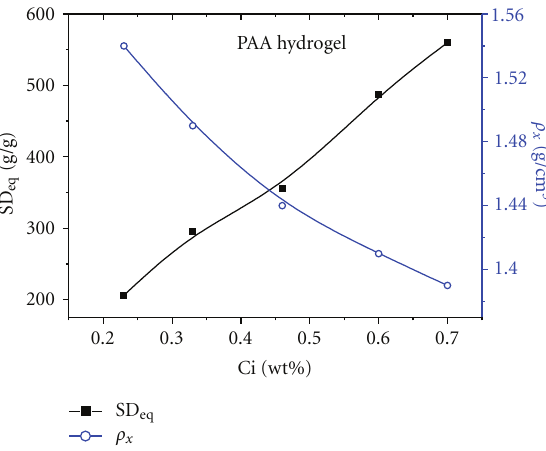
Figure 3: E ff ect of Ci on SD eq and ρ x of PAA xerogels.